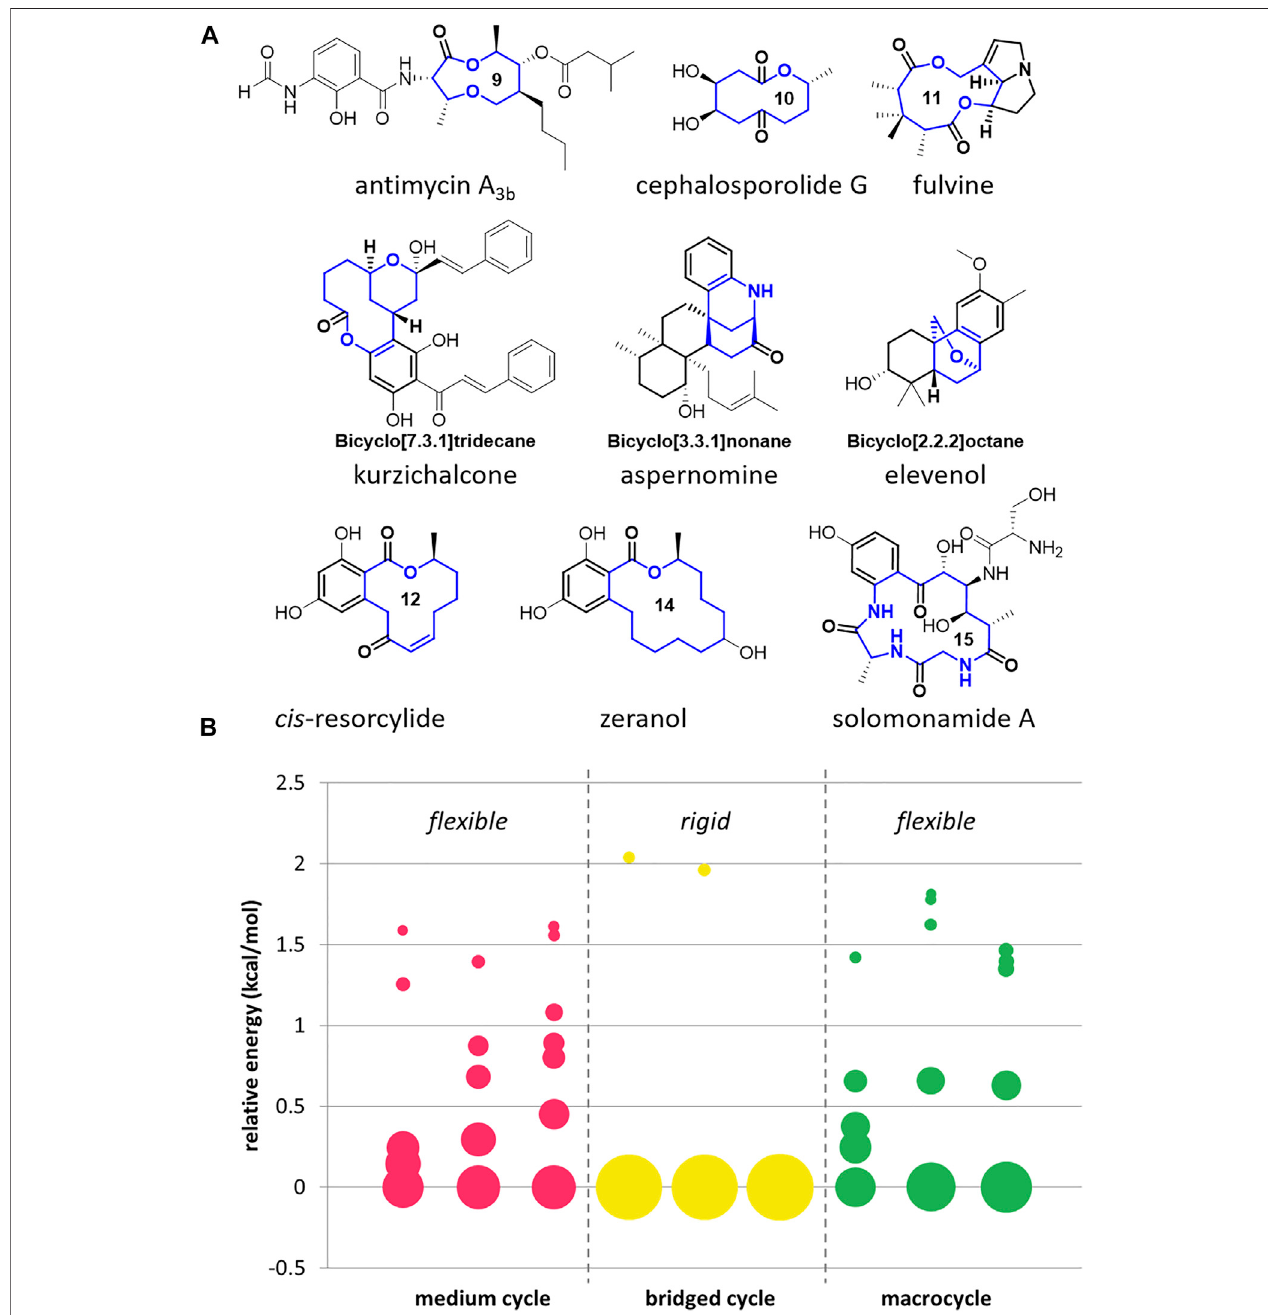
FIGURE 1 | Examples of medium/macro- and bridged rings in bioactive natural products (A) and conformational analysis of their core skeletons (B) .